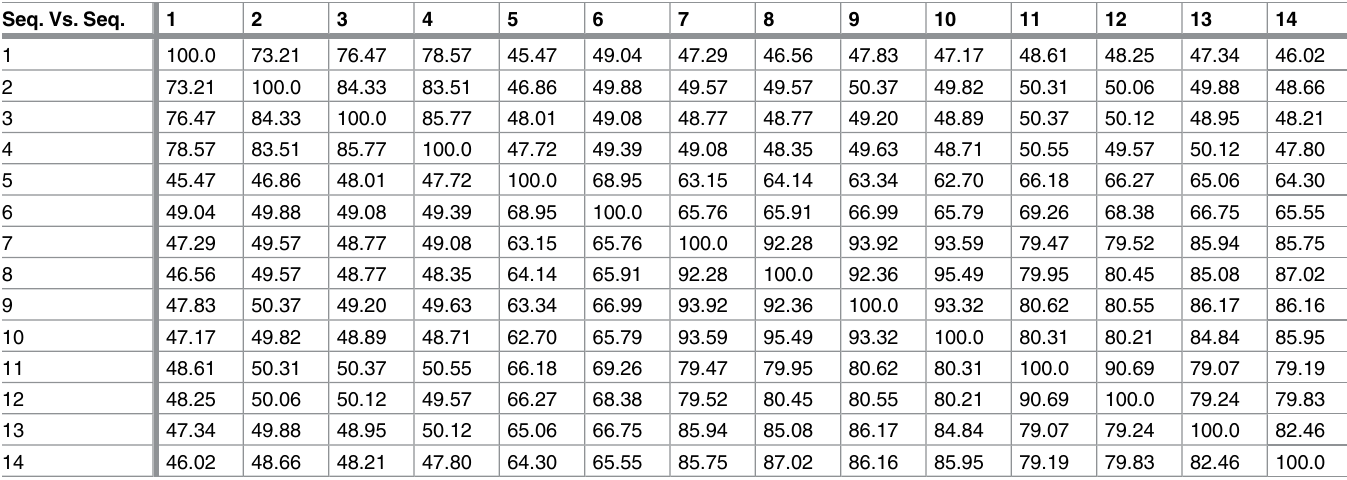
Table 10. Percentage identity matrix of everypair sequences of myosin II head domain by using the site www.ebi.ac.uk/Tools/msa/clustalw2/. Seq. Vs.